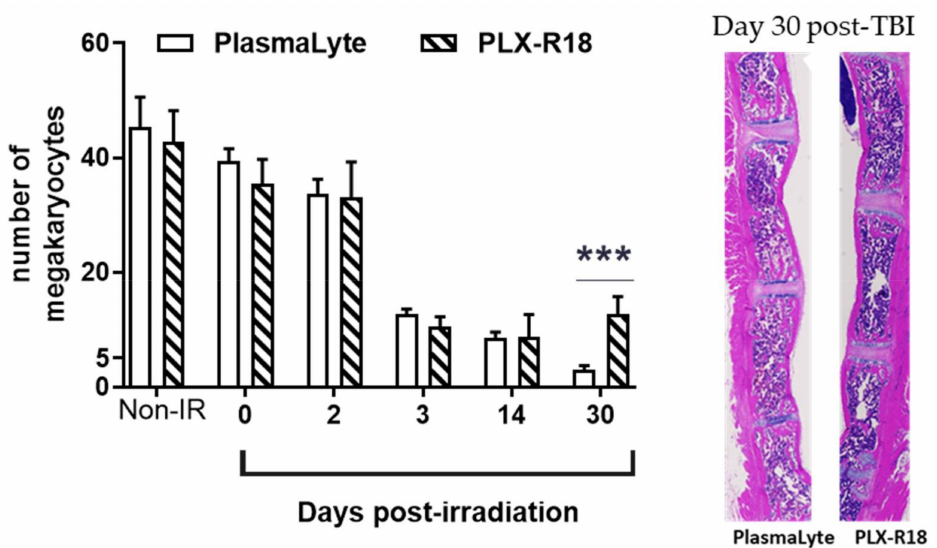
Figure 4. PLX-R18 treatment promoted sternal bone marrow hematopoietic cell recovery after lethal exposure of 8 Gy TBI when administered first dose at 24 h prior to and 3 days post-TBI. Bone marrow megakaryocyte numbers were quantitated from histological sections from days 0 (2 h post-TBI), 2, 3, 14 and 30 post-TBI. Significant increase (indicated as *** p = 0.0011) in bone marrow cellularity and megakaryocytes were observed on day 30 post-TBI in the PLX-R18 treatment group. Data represented are mean ± standard error of the mean (SEM) for n = 8 mice. Representative H&E stained sternal bone marrow sections are shown for PlasmaLyte and PLX-R18 on day 30